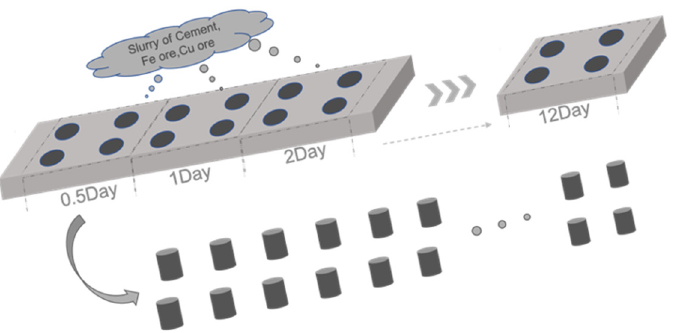
Figure 2. Preparation of cylindrical cement-bonded magnetite-chalcopyrite samples based on vari- ous aging and hydration time (0.5 day, 1 day, 2 days, 3 days, 4 days, 5 days, 6 days, 8 days, 10 days, and 12 days).